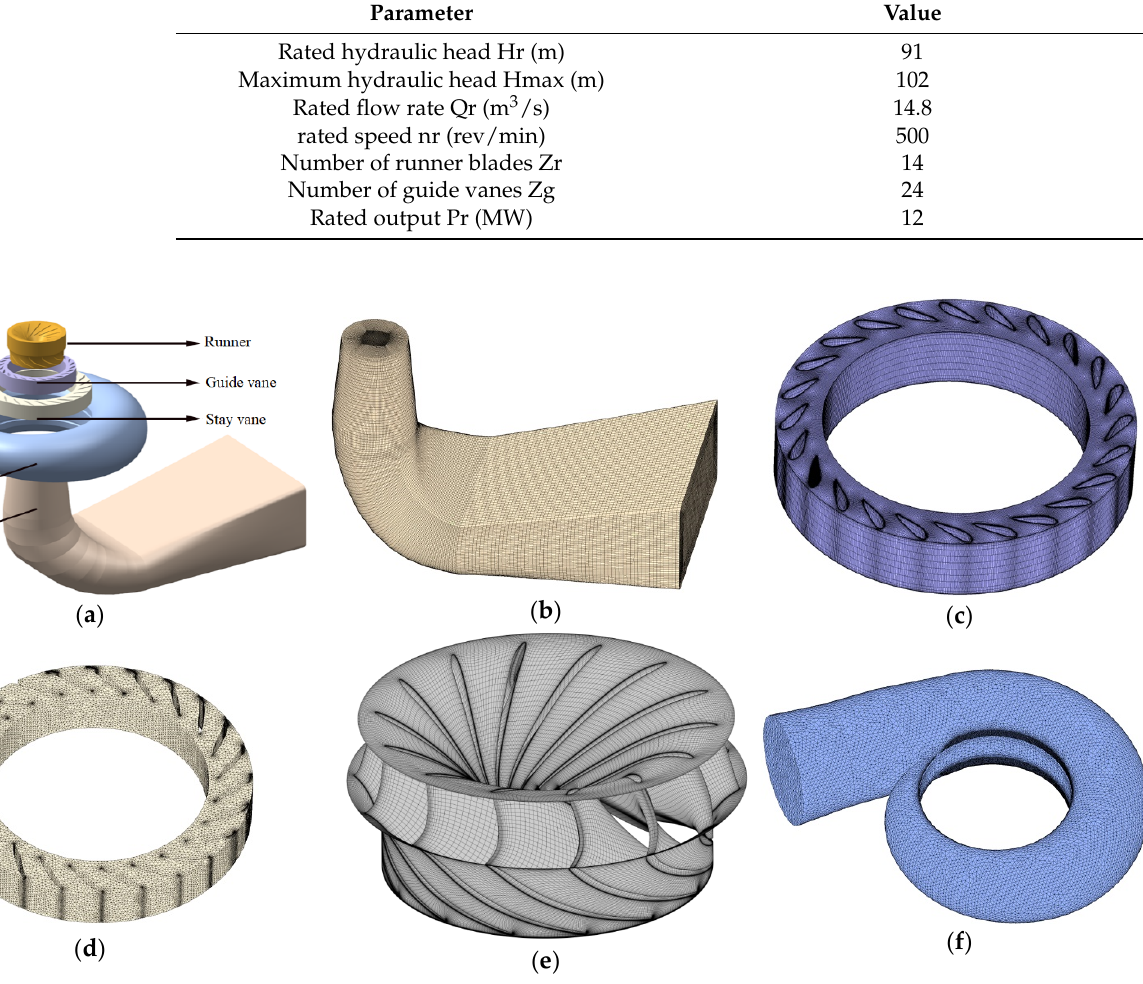
Figure 1. Geometry model of Francis turbine. ( a ) Turbine model, ( b ) draft tube grids, ( c ) guide vane grids, ( d ) stay vane grids, ( e ) runner grids, and ( f ) spiral casing grids.